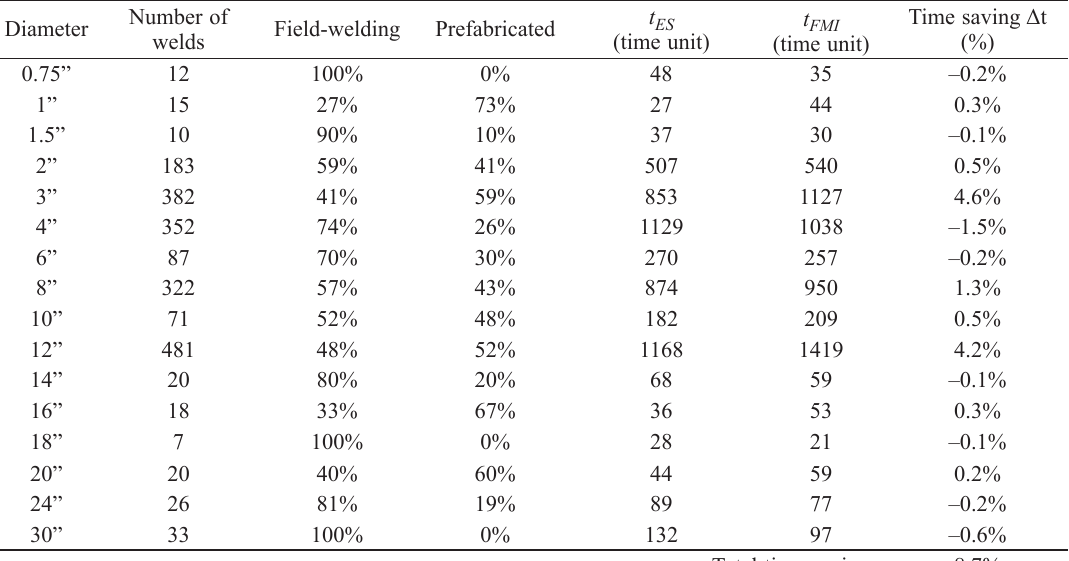
Table 1. Quantity of welds by diameter in comparison between field-welding and prefabricated from the 3D BIM Project Number of Diameter